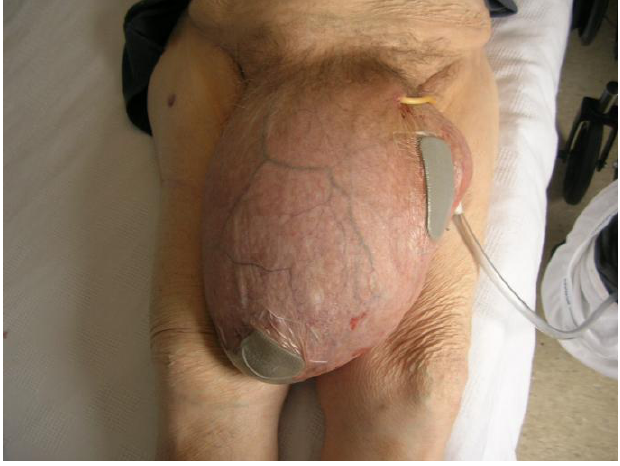
FIGURE. A giant inguinoscrotal hernia extending to the knee